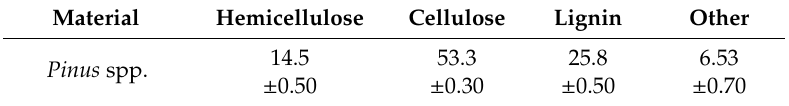
Table 3. Chemical composition of the main structural components of the wood of Pinus spp (%). Material Hemicellulose Cellulose Lignin Other Material Hemicellulose Cellulose Lignin Other Pinus spp. Pinus spp.